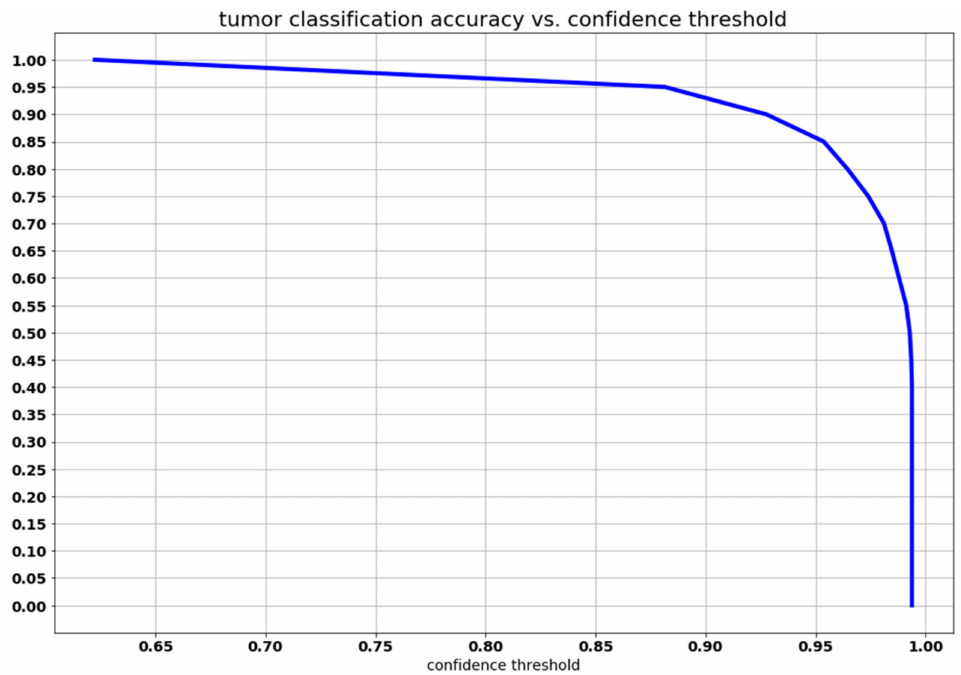
Figure 7. Graph of the relation between the confidence threshold and the precision of the predicted tumor